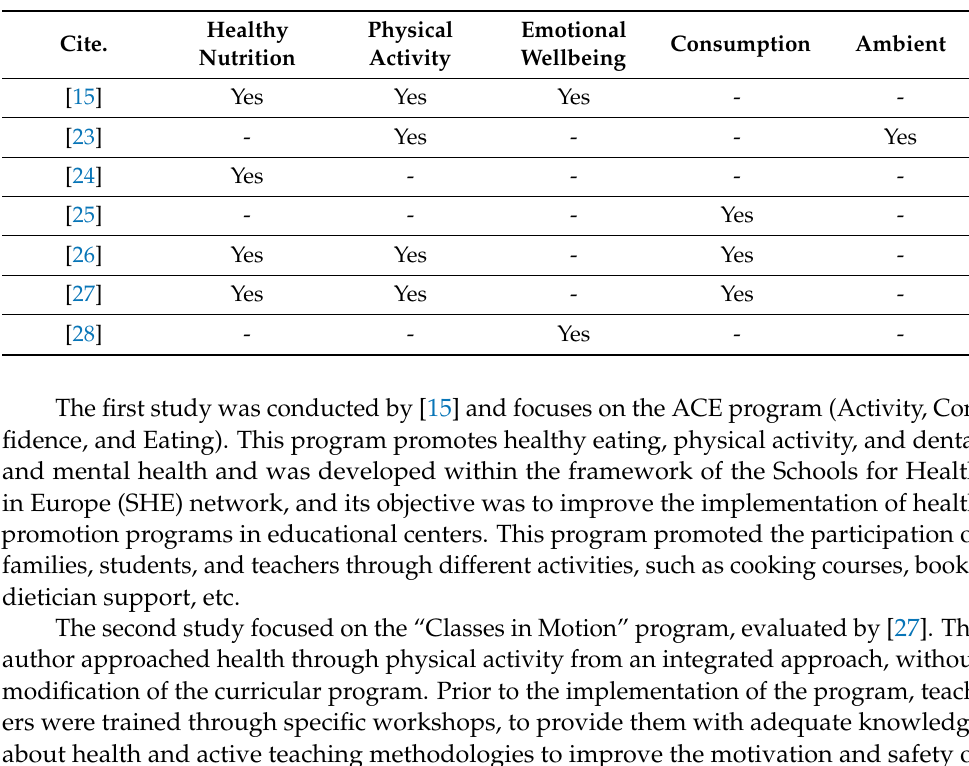
Table 3. Areas of health